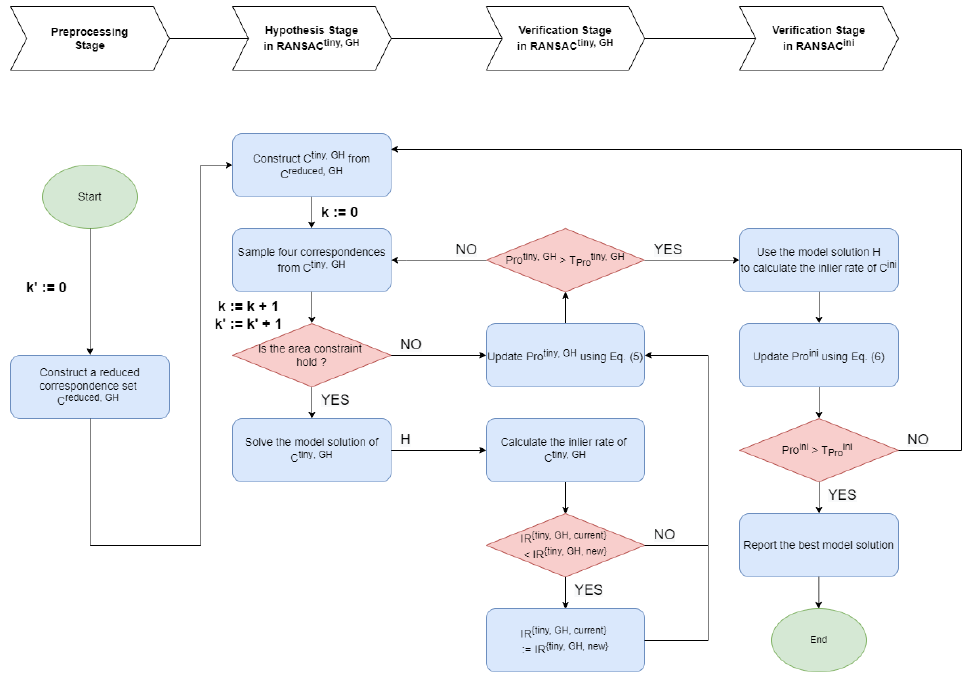
Figure 4. The detailed flowchart of the proposed GH-COOSAC